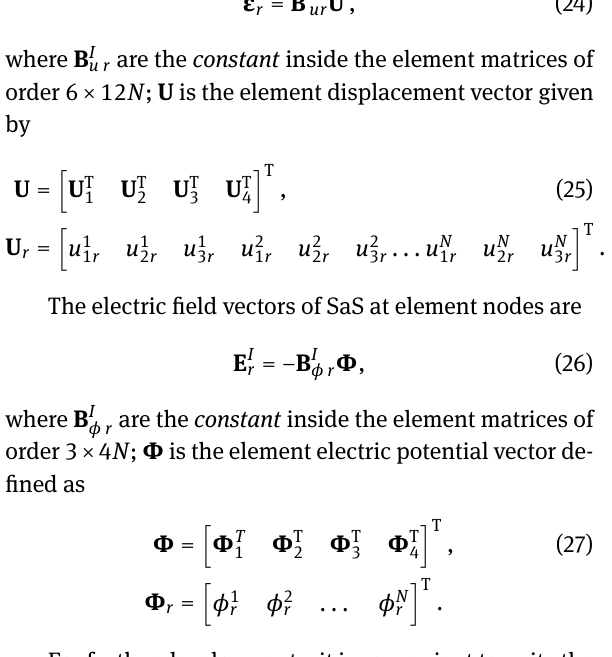
Figure 2: Biunit square in ( ξ 1 , ξ 2 ) -space mapped into the middle surface of the GeX four-node solid-shell element in ( x 1 , x 2 , x 3 ) -